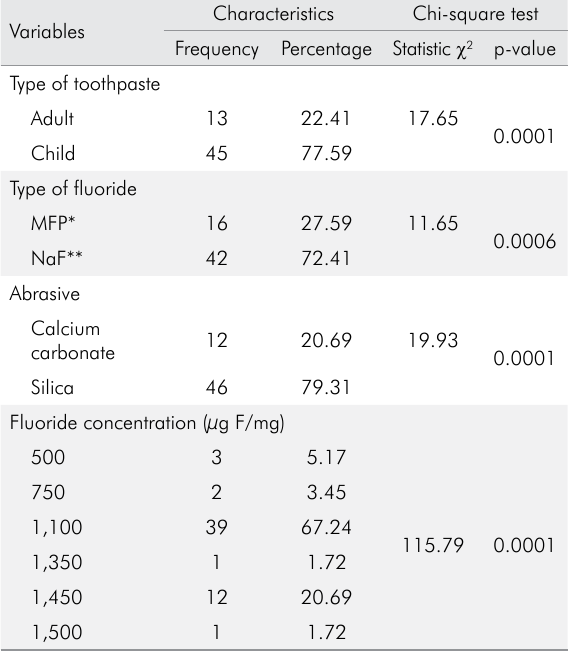
Table 2. Toothpastes characteristics used in the sample and chi-square test for equal proportions between the